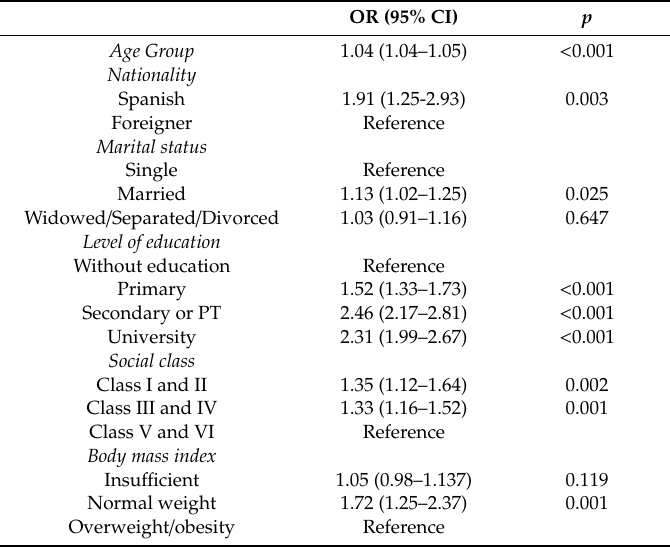
Table 4. Logistic regression model for the association among sociodemographic characteristics and fecal occult blood test in Spanish people aged between 50–69 years